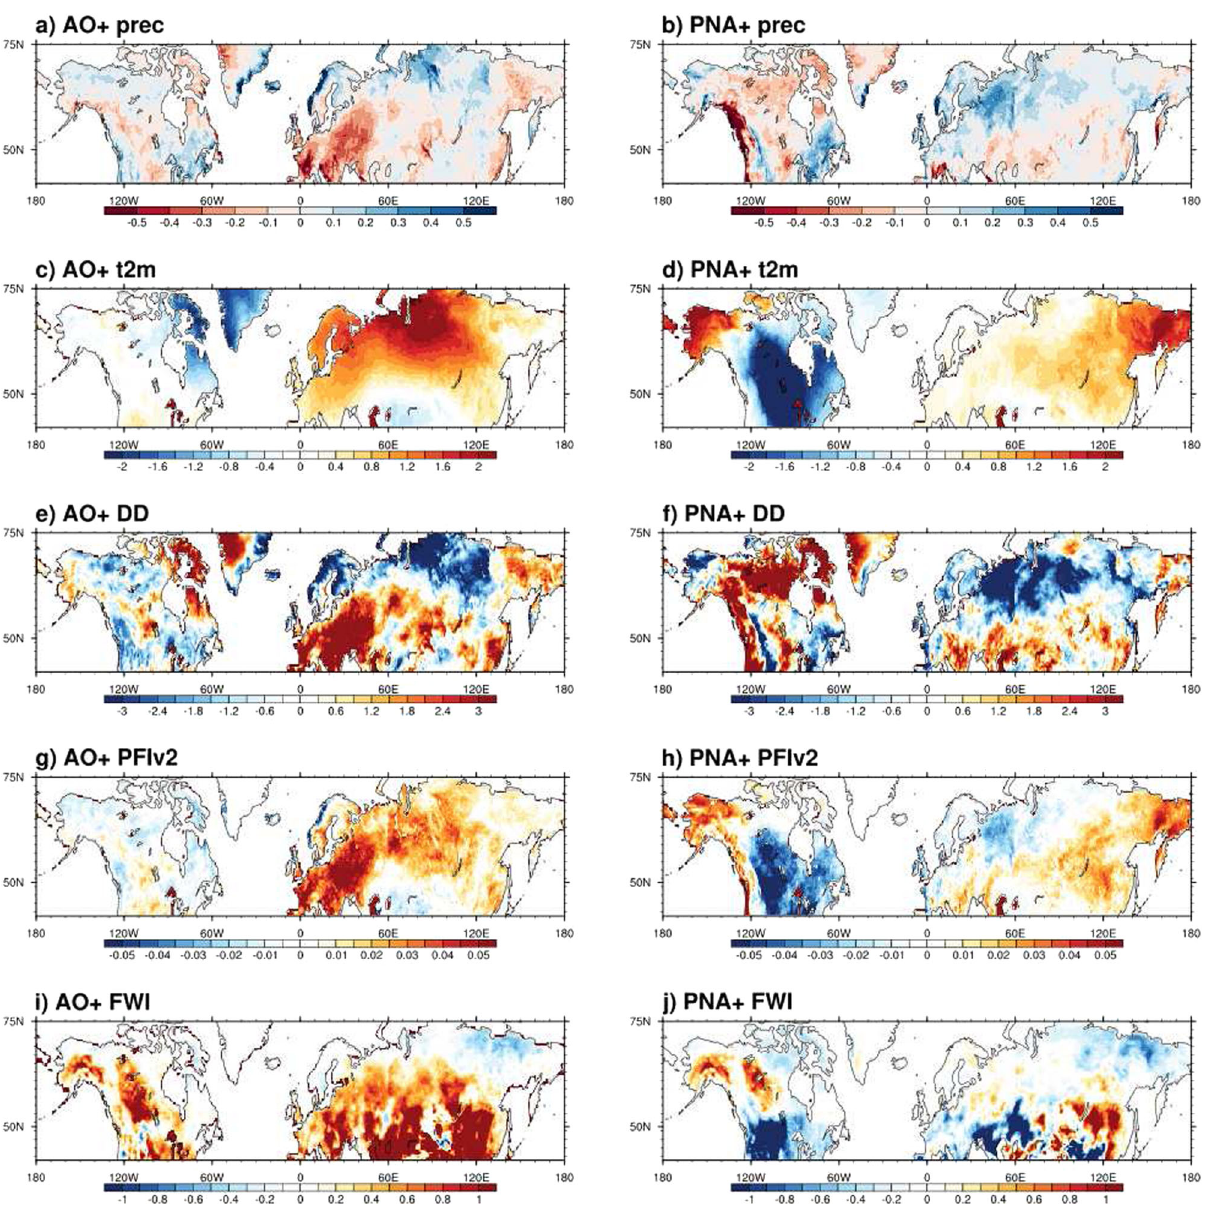
Fig. 1 Composite patterns due to AO + and PNA + . a , b precipitatiom (mm/day), c , d surface temperature ( C ), e , f period of drought, g , h is for the PFIv2, i , j for the FWI. AO + and PNA + exceed 0.5 standard